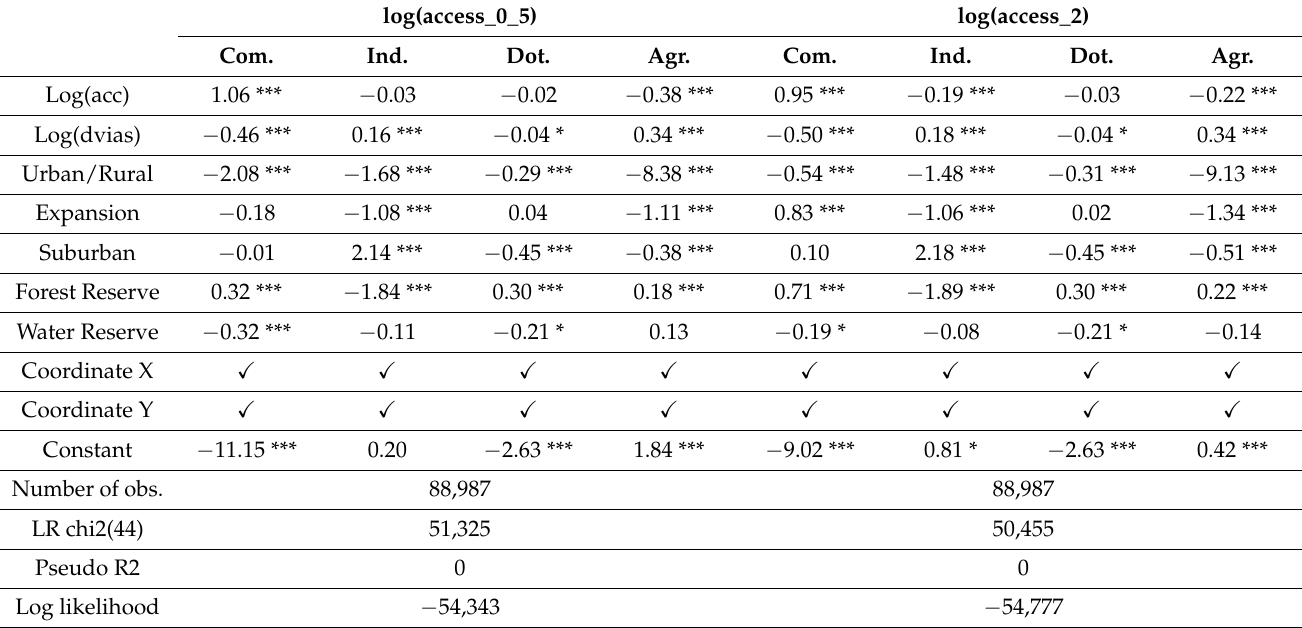
Table 2. Estimation results of the multinomial model of land